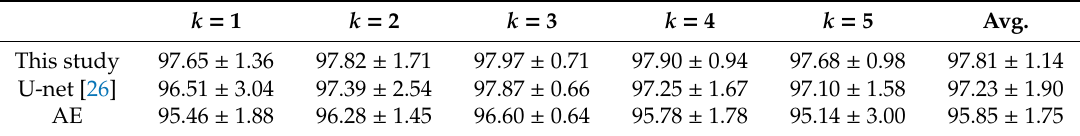
Table 1. Dice similarity coe ffi cient DSC (%) of the proposed system compared with other convolutional neural network- (CNN)-based methods. A five-fold cross-validation process is employed. Each fold ( k ) alternately serves as the unseen testing dataset. (mean ± standard deviation). The auto-encoder (AE) system was built by removing the skip connections of the U-net.